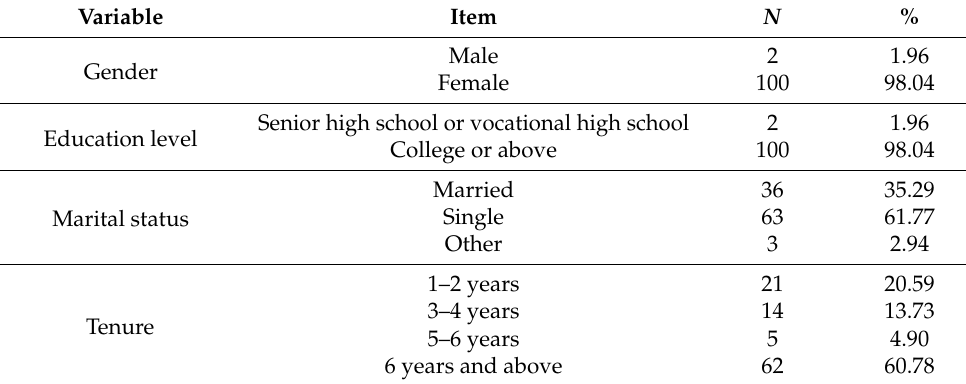
Table 2. Demographic variables of registered nurses ( N = 102).